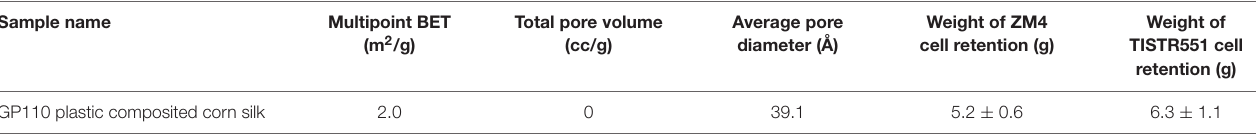
TABLE 1 | Analysis of the surface area of a carrier using Brunauer–Emmett–Telle analysis and the weight of ZM4 and TISTR551 cell retention on GP110 plastic composited corn